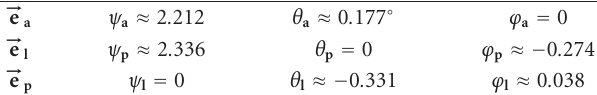
Table 2: Euler angles in radian which define the perpendicular of each